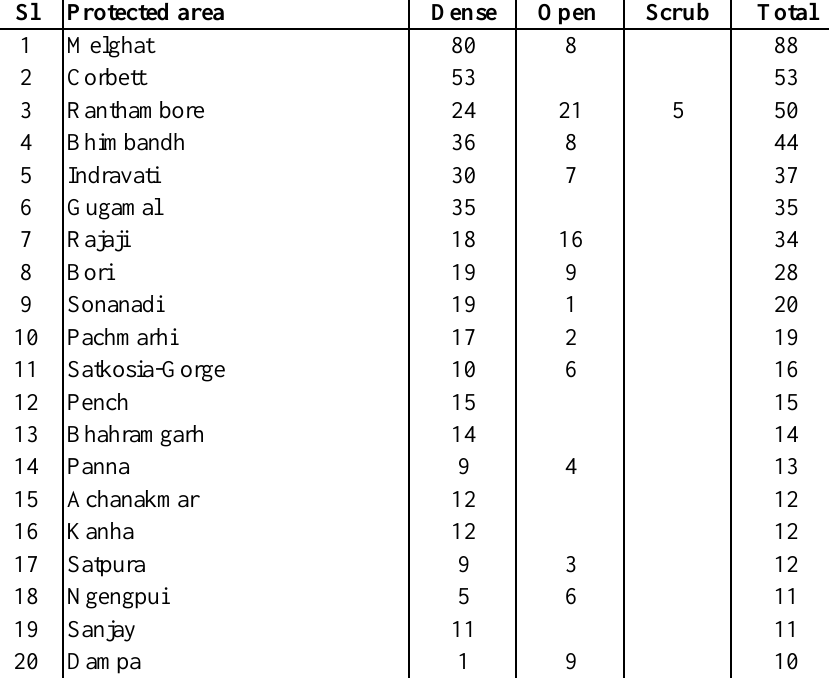
Table 3. Fire distribution in forest density classes using A(A)TSR night-time data for some protected areas in India (1997–2005).